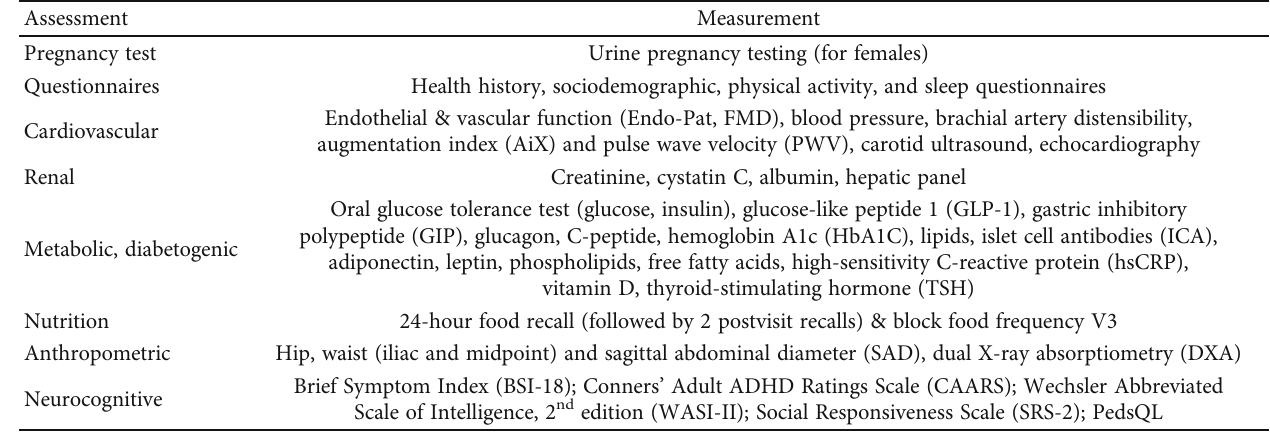
Table 1: The TEAM Study visit procedures, methods, lab tests, and assessments. Assessment